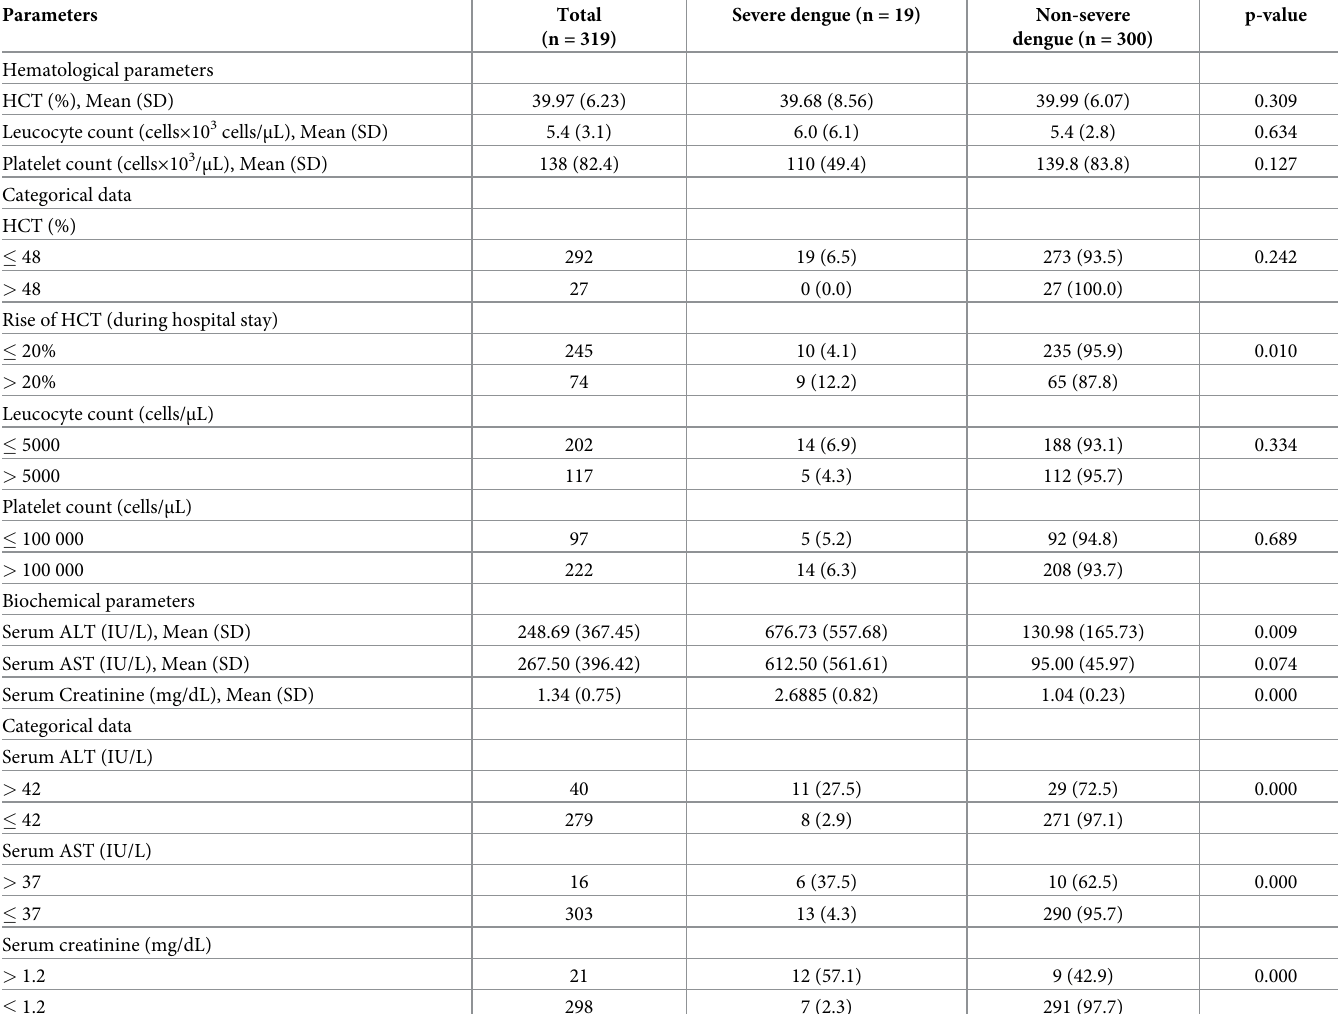
Table 3. Hematological and biochemical parameters of dengue cases (n =